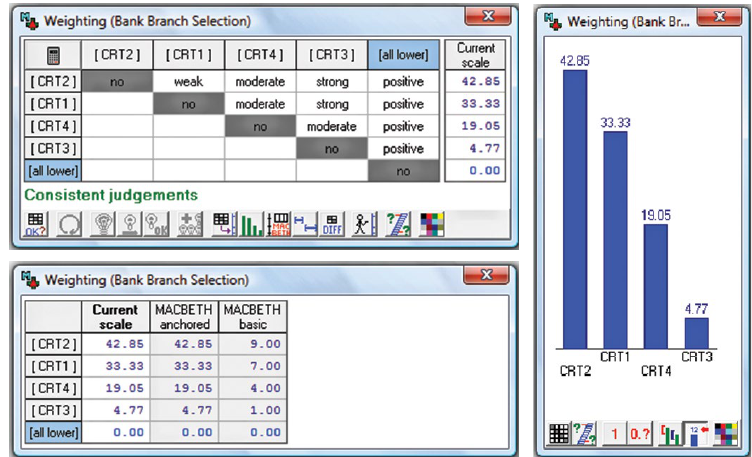
Fig. 7. Value judgements, proposed scales and criteria